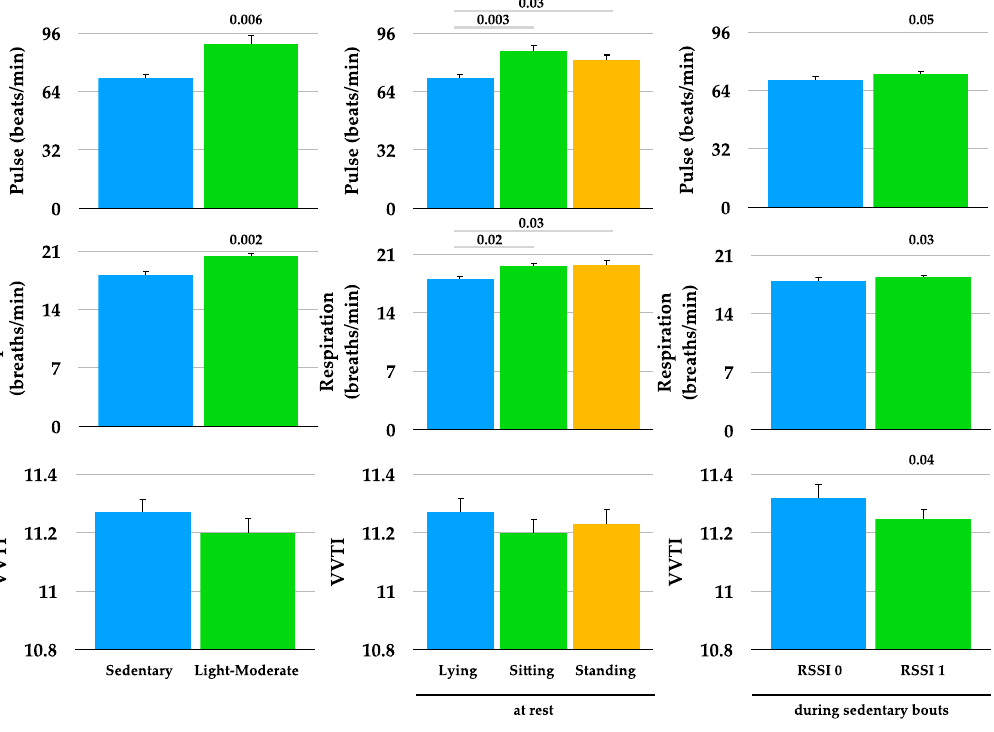
Figure 3. Mean ± SE pulse, respiration, and heart rate variability (VVTI) during sedentary and light-moderate bouts ( left panel ), at rest during lying, sitting, and standing ( middle panel ), and during sedentary bouts in the absence of RSSI signal (RSSI 0) and in the presence of RSSI signal (RSSI 1) ( right panel ). Note for VVTI that y-axis starts at 10.8 (not 0). Table 4. Predictors of pulse during sedentary